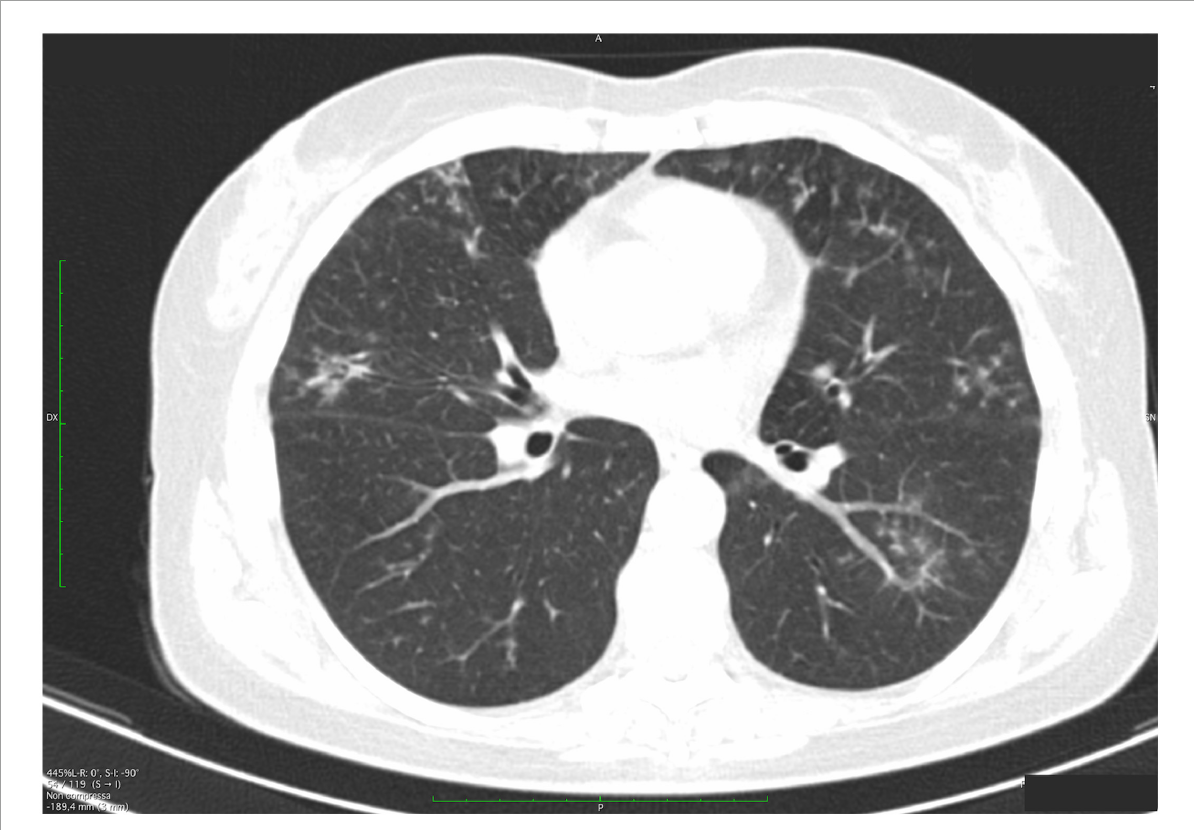
FIGURE4 High-resolution computed tomography (HRCT) axial scans of a patient with primary Sjögren’s syndrome (pSS). The patient was a 54-year-old woman with a mild non-productive cough. Multiple semisolid and ill-defined margins centrilobular small nodules are observed, predominantly along the subpleural region, with subpleural interlobular septal thickening. In the right upper lobe, bronchiectasis and early cysts with adjacent peribronchiolar ground-glass thickening are